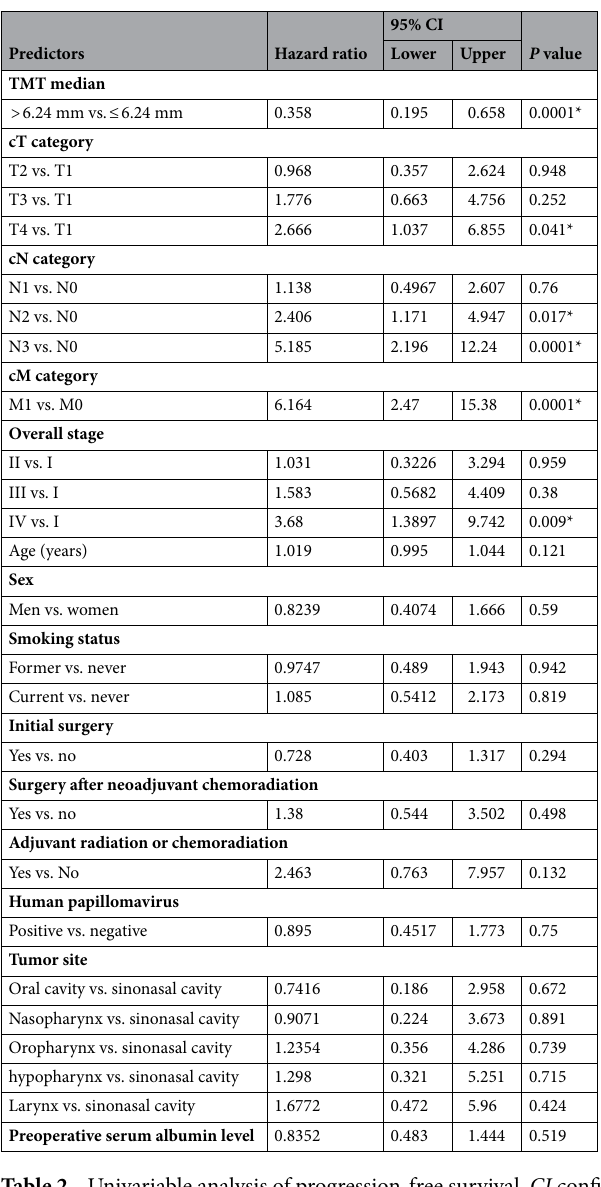
Table 2. Univariable analysis of progression-free survival. CI confidence interval, TMT temporalis muscle thickness, cT clinical tumor, cN clinical node, cM clinical metastasis. * P value less than 0.05 indicates statistical